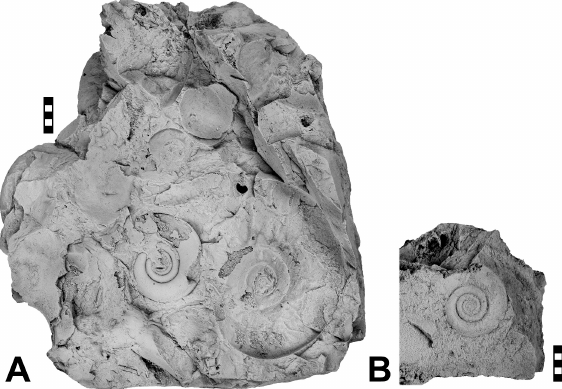
Fig. 22. Acanthoclymenia planorbis (Sandberger & Sandberger, 1851). A . Specimen MB.C.30438 (Koch Coll.) from Oberscheld. B . Specimen MB.C.30439 (Kauth Coll.) from Oberscheld (Königszug Mine). Scale bar units = 1